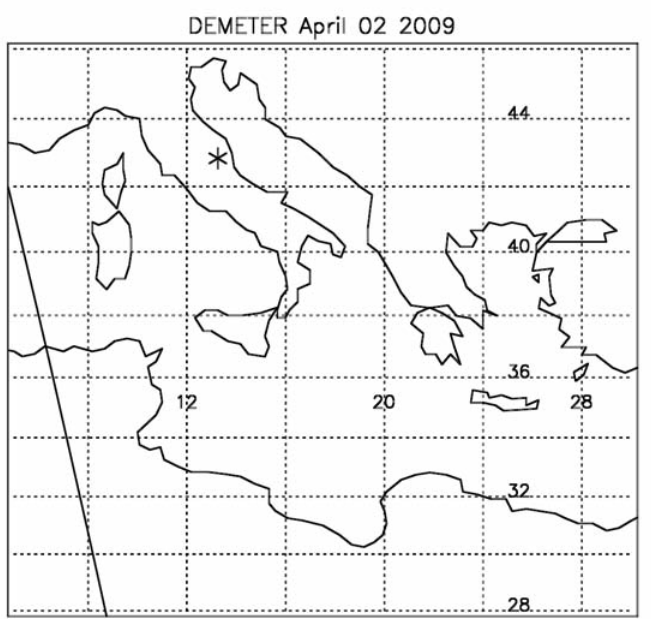
Figure 4. Map showing the epicenter of the April 6 L’Aquila earthquake (*) and the orbit of the DEMETER satellite on April 2, 2009. The point of closest approach from the epicenter was 60